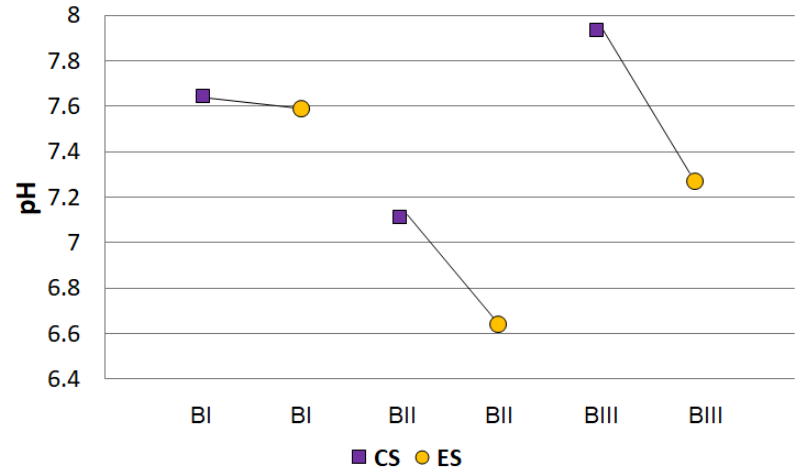
Figure 2. The changes in pH values for samples from the experimental system (ES) and the control system (CS).